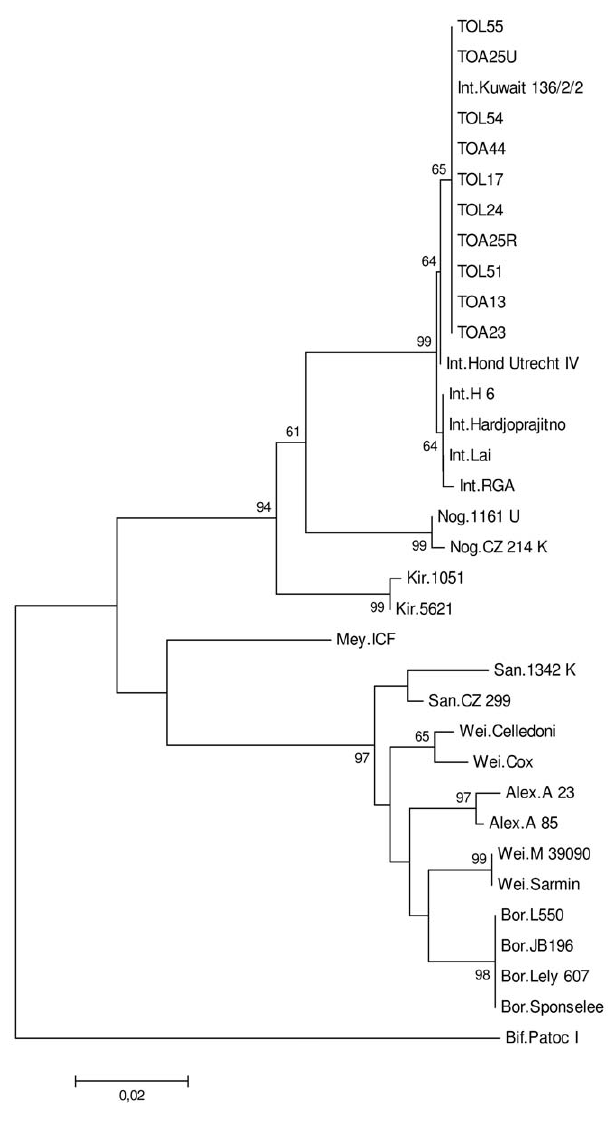
Figure 2. Phylogenetic tree based on Tamura-Nei distances and developed with the neighbor-joining method. Distances were calculated from G1–G2 restricted sequences and are based on 10 Leptospira strains isolated from rats in Madagascar (TOL55, TOL54, TOL51, TOL24, TOL17, TOA44, TOA25U, TOA25R, TOA23 and TOA13, GenBank accession numbers HM639728-HM639737). The remaining sequences are reference strains, including Leptospira interrogans (Int.) strains Lai, Hond Utrecht IV, Hardjoprajitno, Kuwait 136/2/2, H 6, RGA,